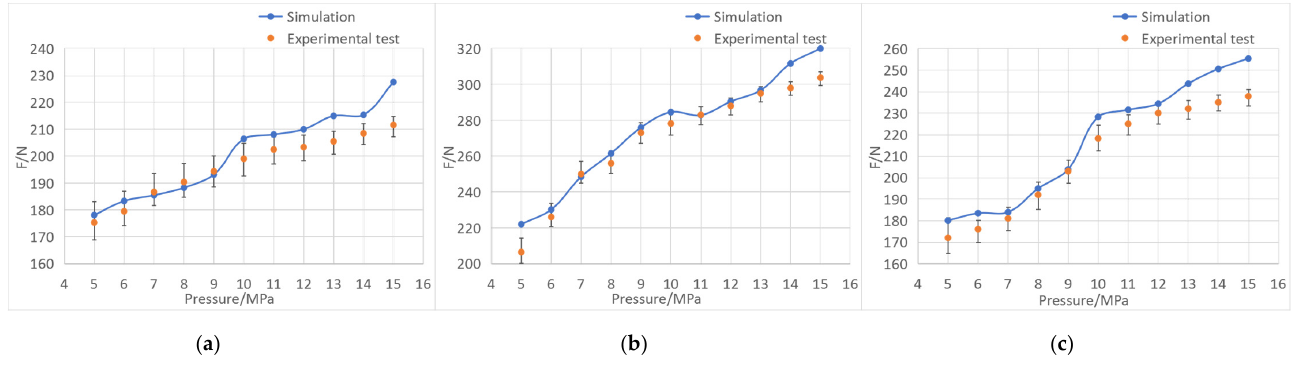
Figure 9. Comparison of suction force results of simulation with cavitation model and experiment of suction cup- θ 20. Gap clearance is ( a ) 1 mm; ( b ) 1.5 mm; ( c ) 2 mm.